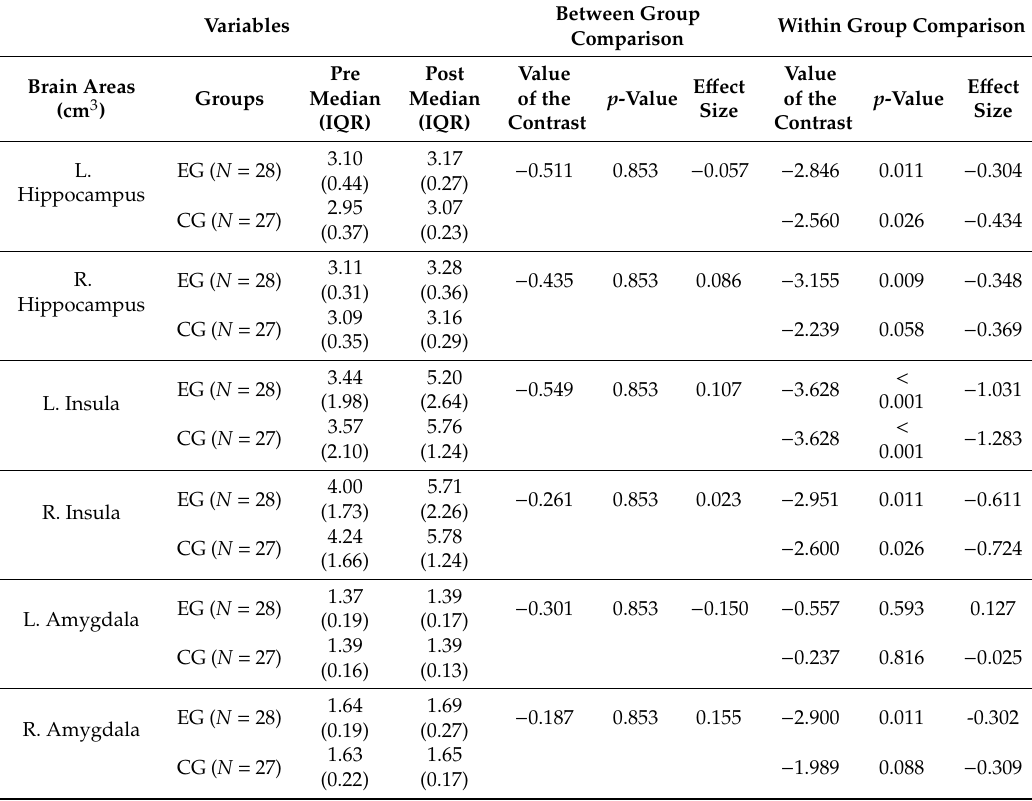
Table 3. Intent-to-treat analysis of the e ff ects of exergame intervention on the di ff erent brain structures, the pVO2, and the